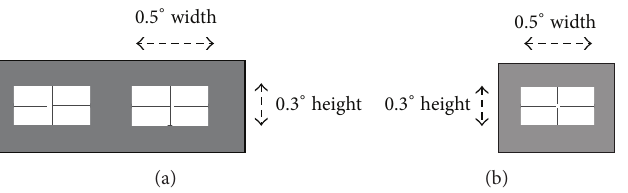
Figure 1: Saccadic stimuli for identification of fine features (after [7]). For a feature identification task, one of two stimuli (a) was presented with a single pixel offset either left or right, either target being presented randomly left or right of central fixation. In a no identification task, stimulus on the right (b) with a central pixel was presented in the same manner.